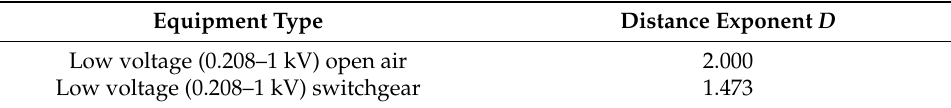
Table 1. Equipment type and his distance exponent x .